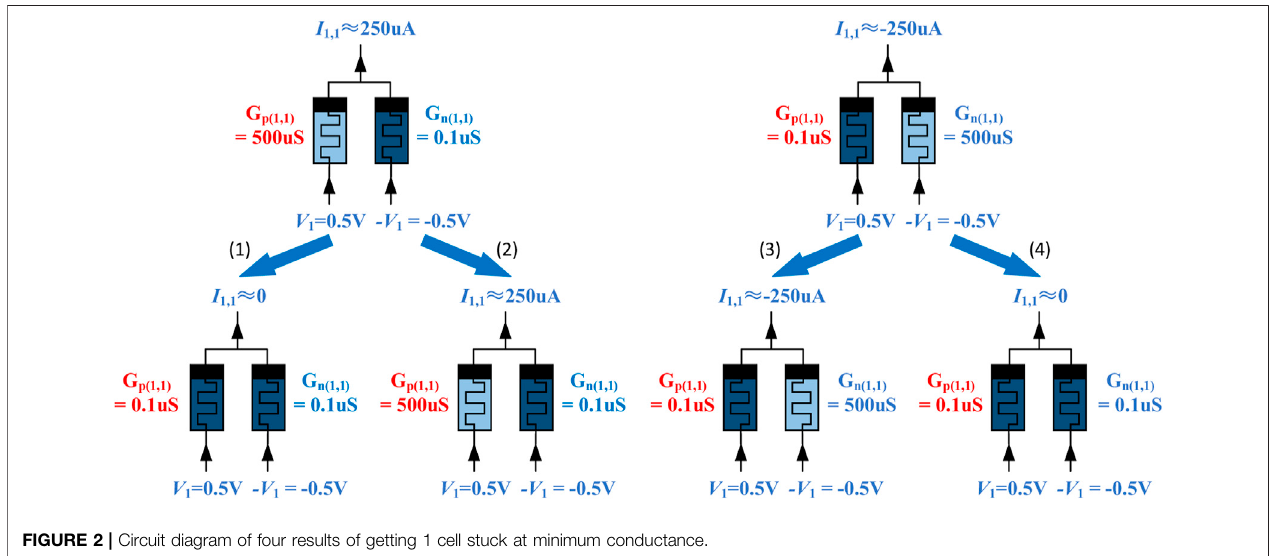
FIGURE 2 | Circuit diagram of four results of getting 1 cell stuck at minimum conductance.